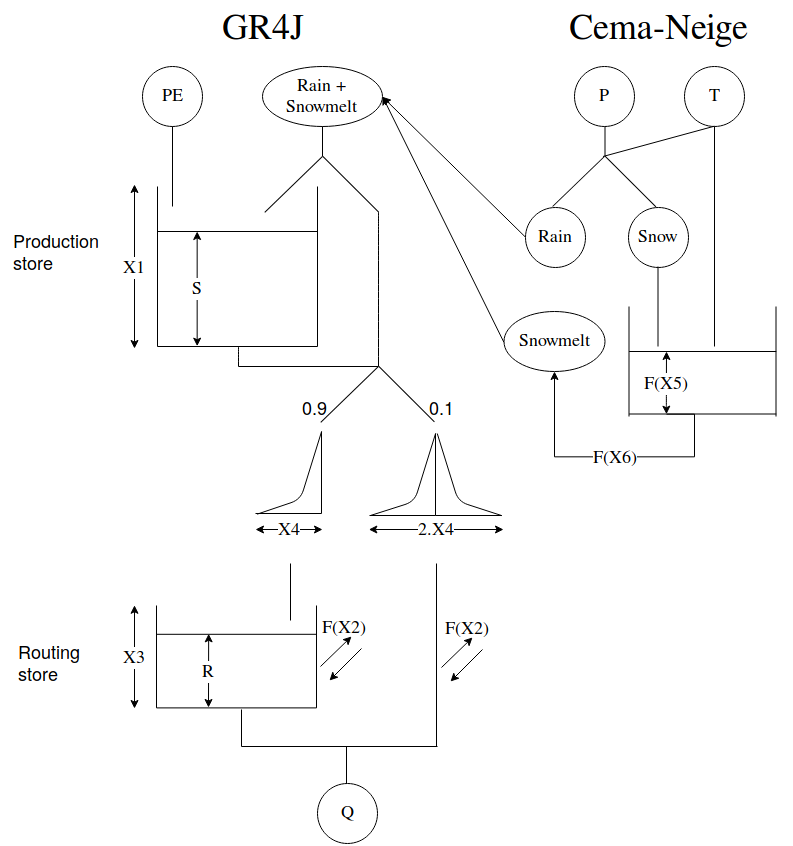
Figure 3. Conceptual schemes of GR4J hydrological model [27] and Cema-Neige snow accounting routine [28,29]. Table 1. Description and calibration ranges for GR4J and Cema-Neige free